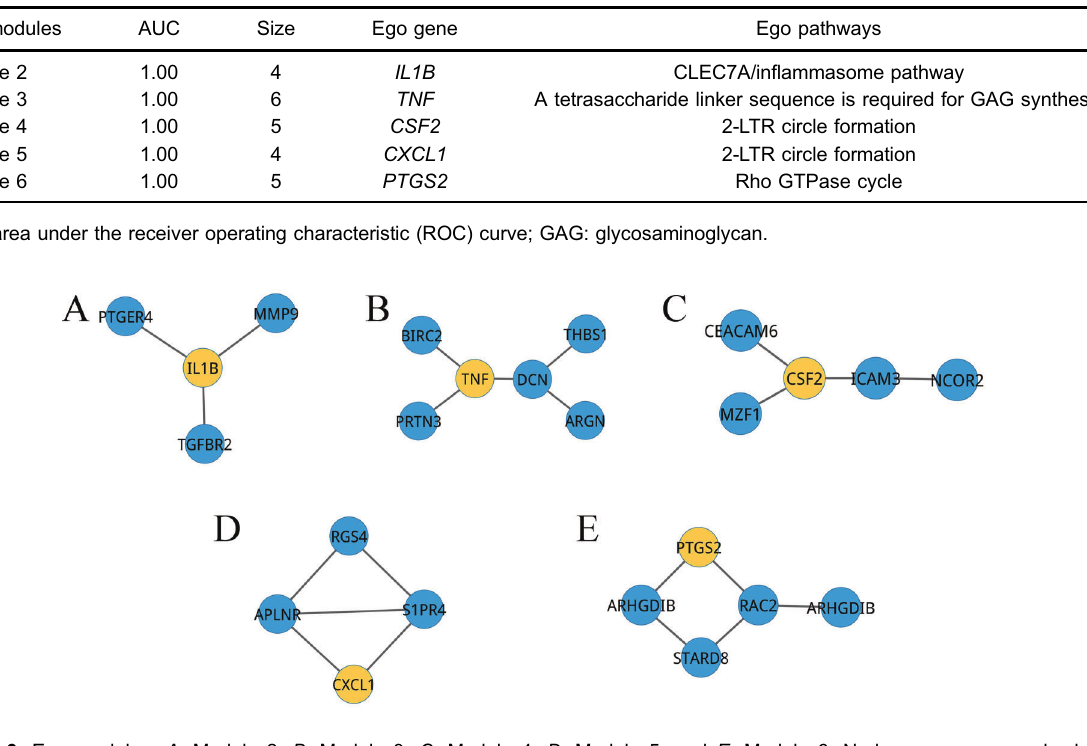
Figure 3. Ego modules. A , Module 2; B , Module 3; C , Module 4; D , Module 5; and E , Module 6. Nodes are genes, and edges represented interactions between any two genes. The yellow nodes are the ego genes of the